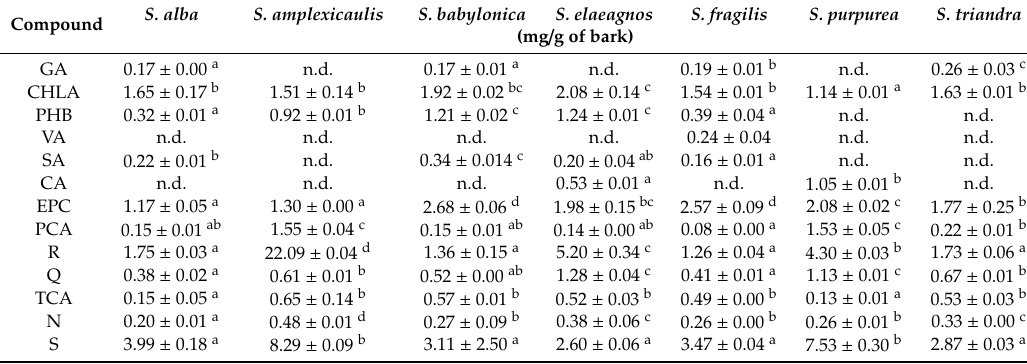
Table 2. Phytochemical characterization of bark extracts.